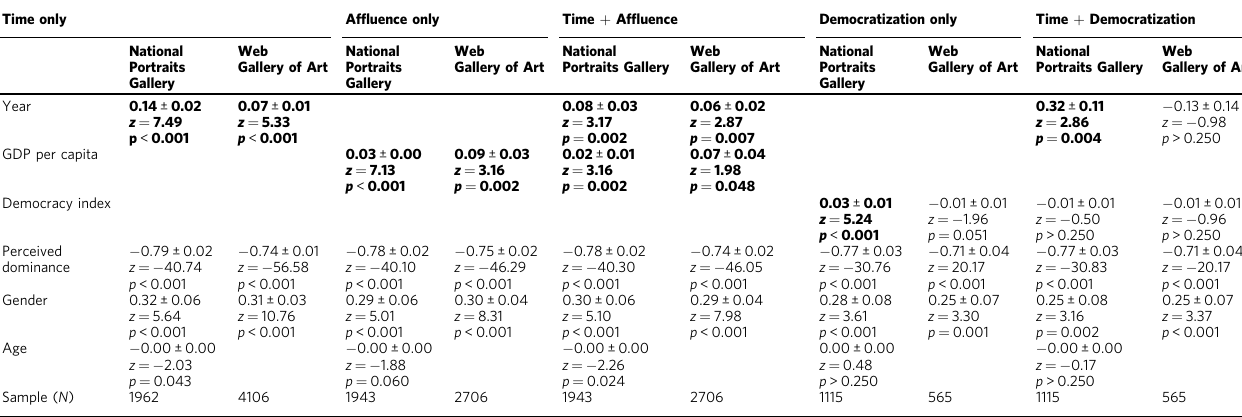
Table 1 Effect of time, GDP per capita and democratization on ratings of perceived trustworthiness in the portraits of National Portrait Gallery and the Web Gallery of